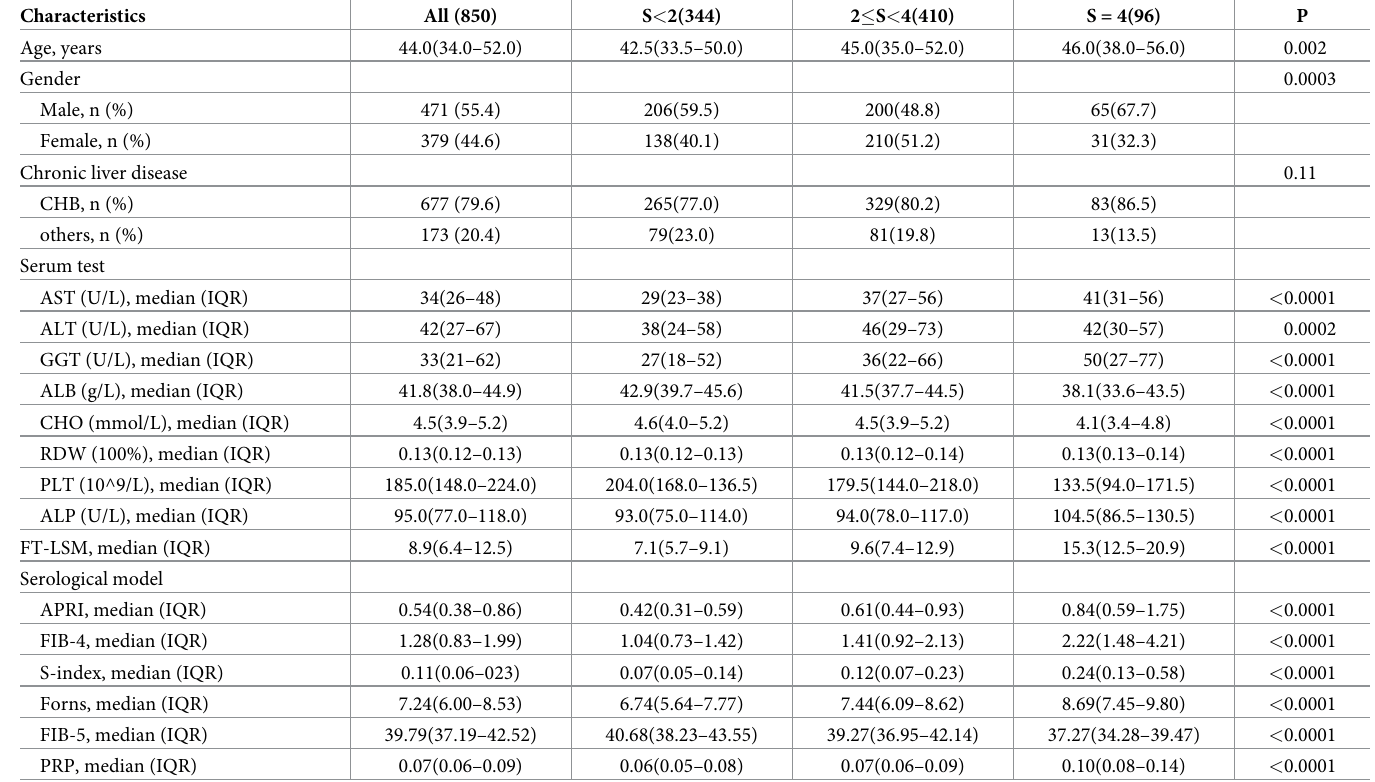
Table 1. The characteristics of 850 chronic liver disease patients from 2016 to 2021, Hangzhou, Zhejiang, China. Characteristics